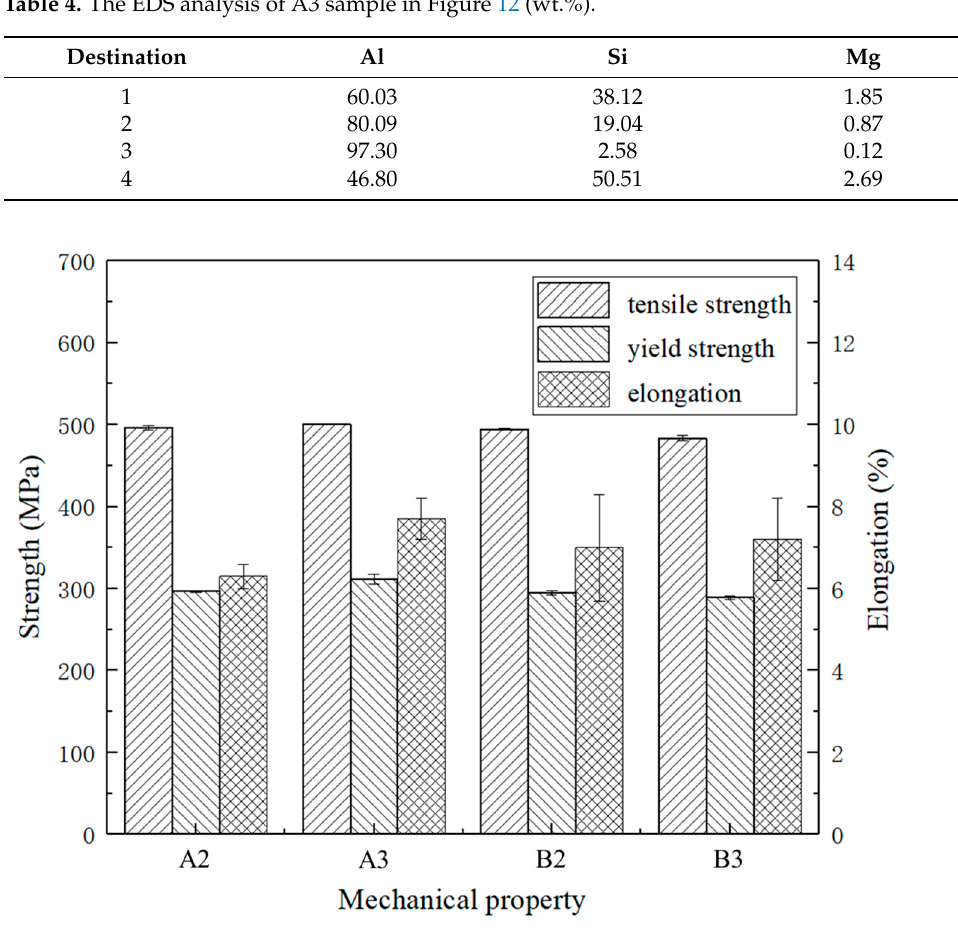
Figure 11. The microstructure morphology of the samples treated by deep ‐ etching: ( A ) Process A2; ( B ) Process A3; ( C ) Process B2; ( D ) Process B3.